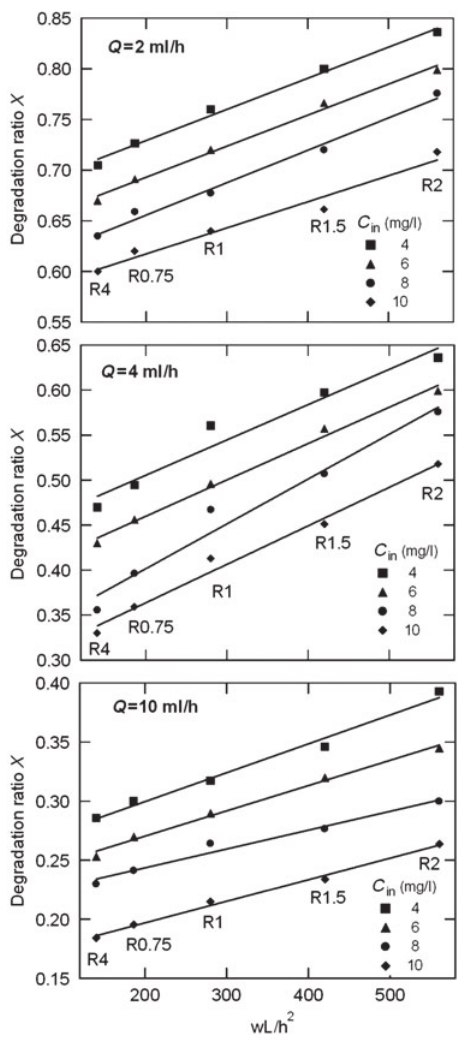
Figure 6 Degradation of salicylic acid as a function of the dimensi- ons of the microchannel reactors ( wL / h 2 ) for different inlet concen- trations ( C ) and flow rates ( Q). w refers to the channel width, L to in the channel length, and h to the channel height. The lines represent the best linear fits given by X = a ( wL / h 2 ).